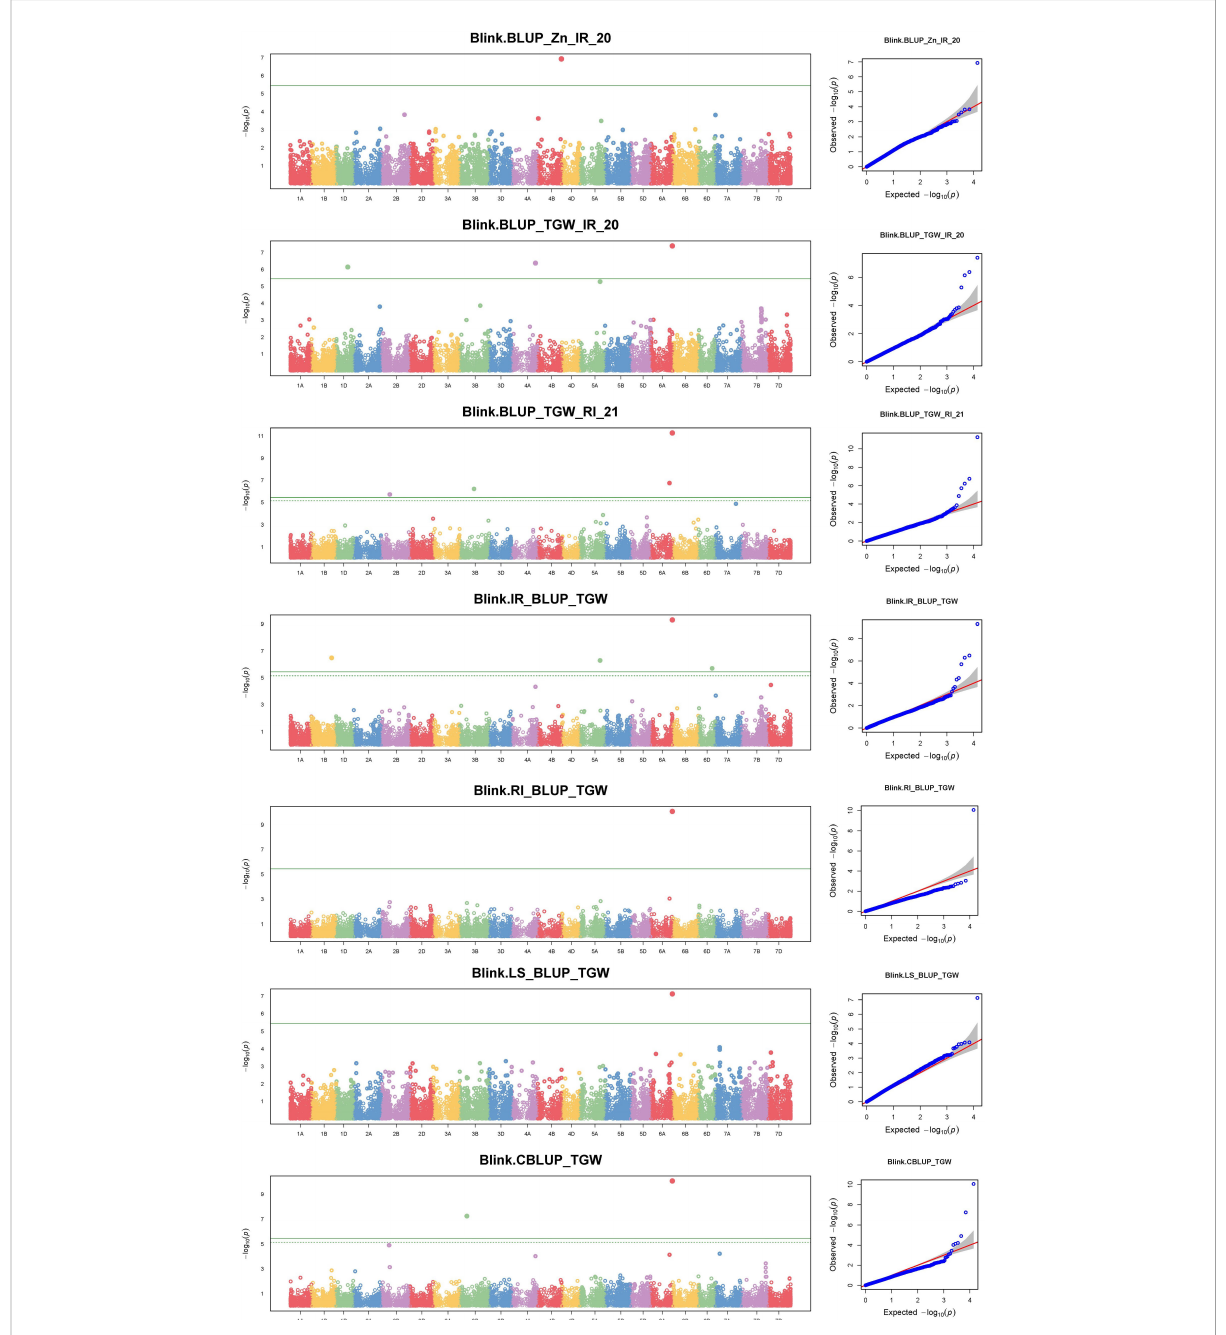
FIGURE 8 Manhattan and respective Q – Q plots of signi fi cant associations for GZnC and TGW under IR, RI, LS, and combined